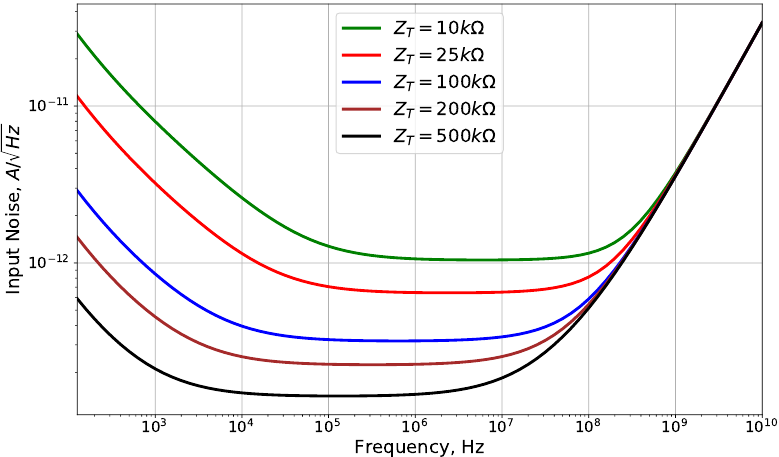
Figure 6. Analytically calculated input-referred noise model for programmable-gain configuration with M 1 thermal noise component, noises due to R bias,1 , R 2 and flicker noise on M 1 (example case for TSMC 0.18 µ m CMOS).